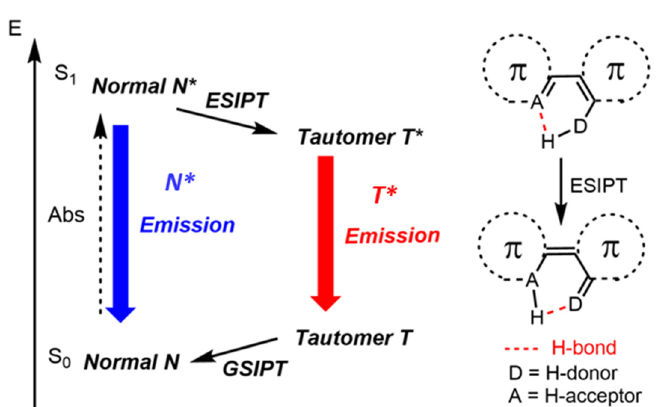
Figure 2. Schematic representation of the four-level phototautomerization process of ESIPT. * represents the excited species.